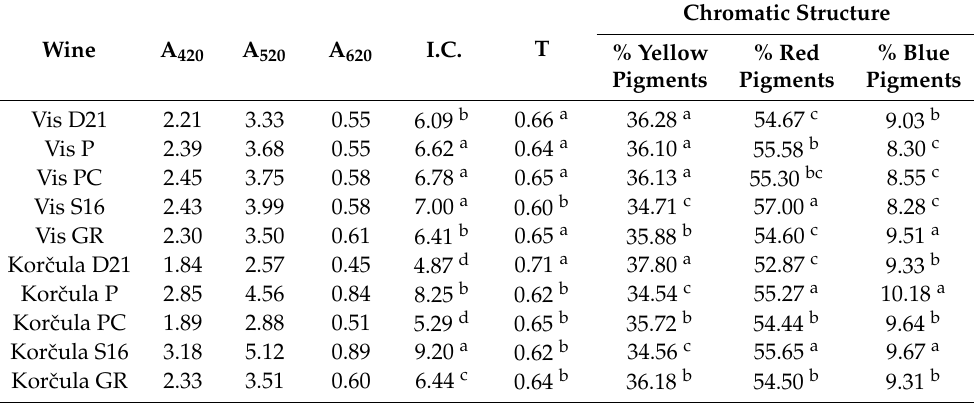
Table 5. Chromatic parameters of Plavac mali